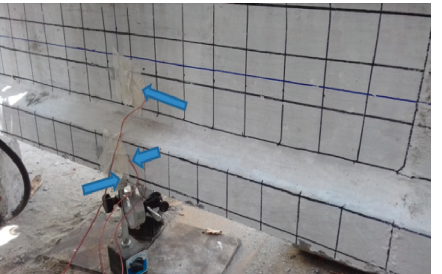
Figure 5: Installation of strain and deflection gauges (arrows in- dicate the position of strain gauges).